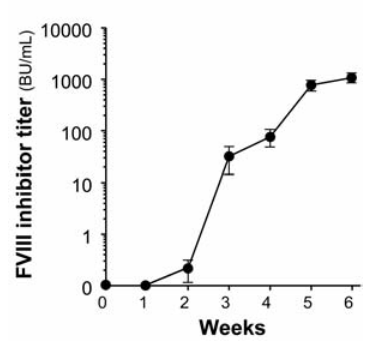
Figure 2. Progressive increase of factor VIII (fVIII) inhibitor titers in hemophilia A mice by weekly intraperitoneal administra- tions of recombinant human fVIII (rhfVIII) (n=6-8). Inhibitor titers reached a plateau after the fifth administration of